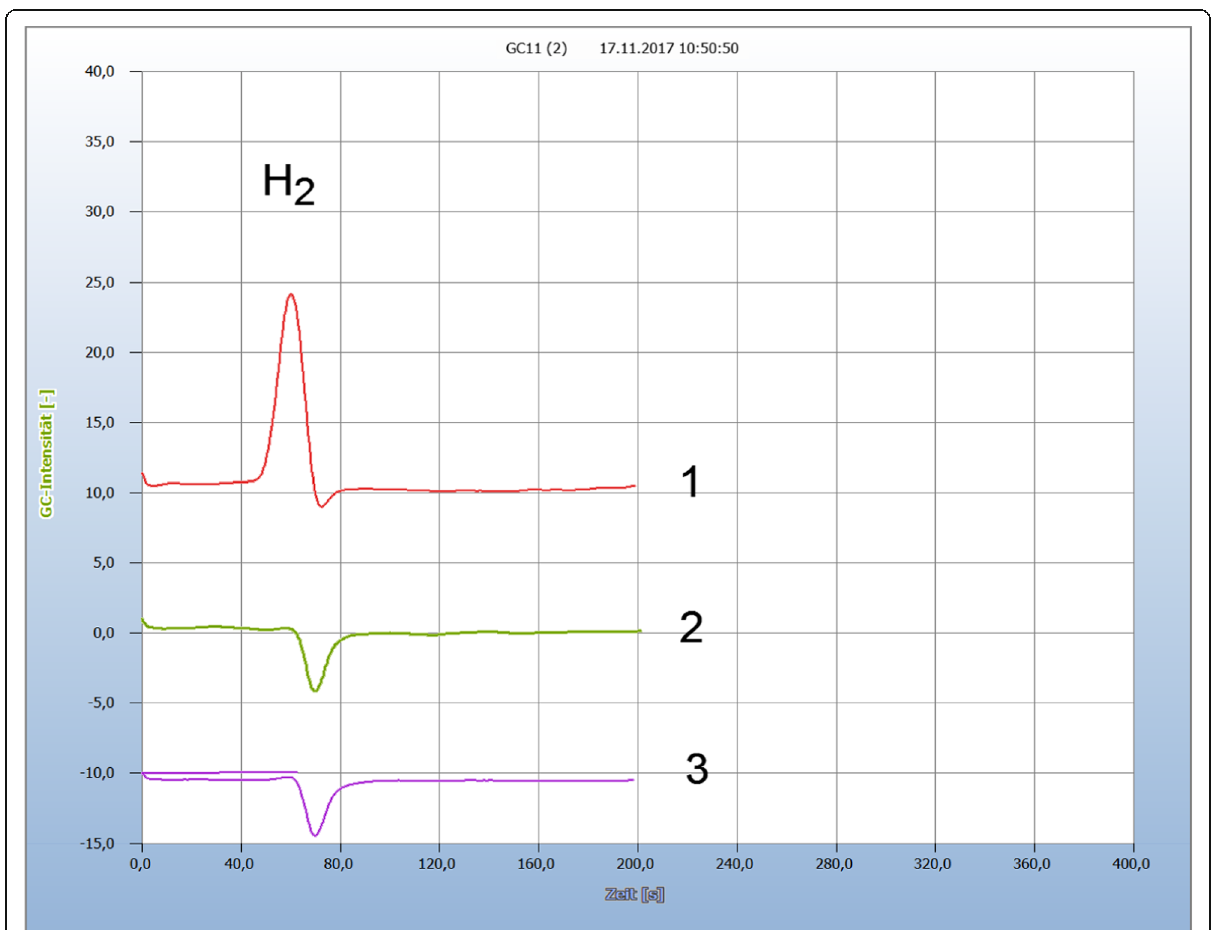
Fig. 3 Obligate bacteria in the colon. 1, sample under nitrogen atmosphere in the vial; 2, sample under ambient air in the vial; 3, blank of pure cotton head from cotton bud in nutrient medium. GC-column 1: silica